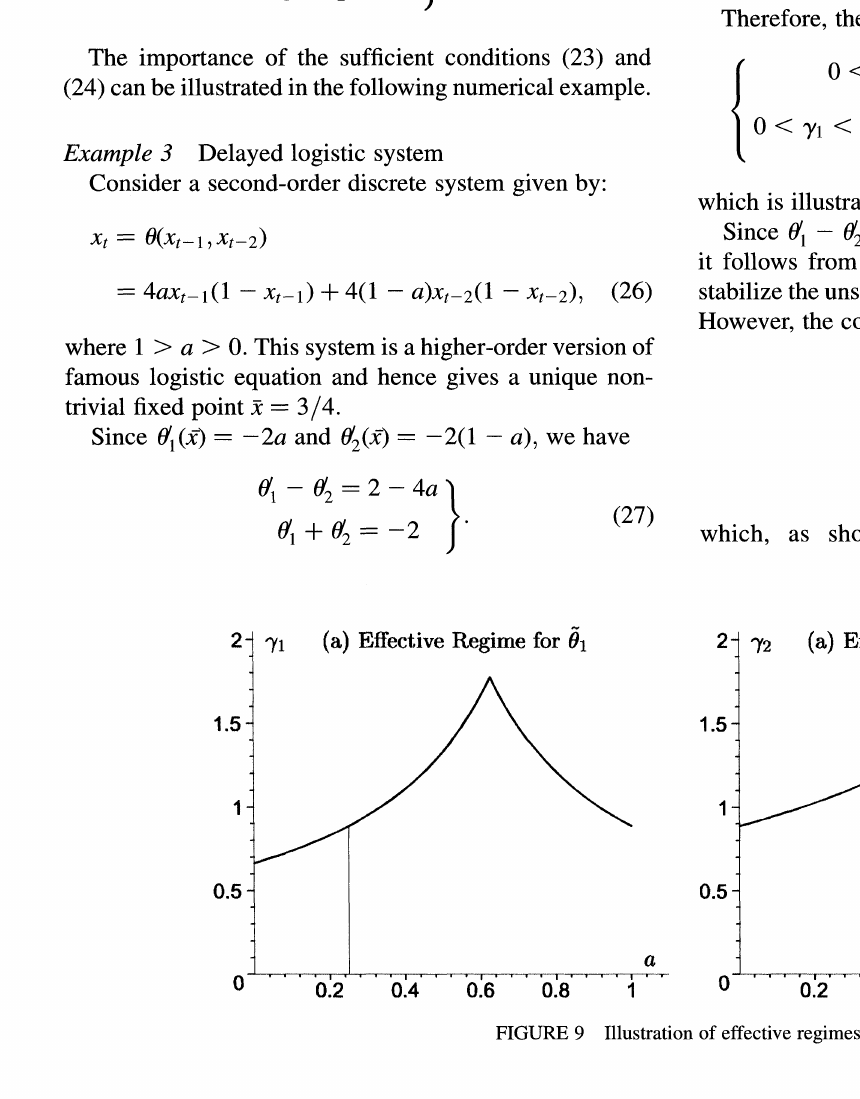
FIGURE 8 Bifurcation of Ot O(Xt-l,Xt-2).